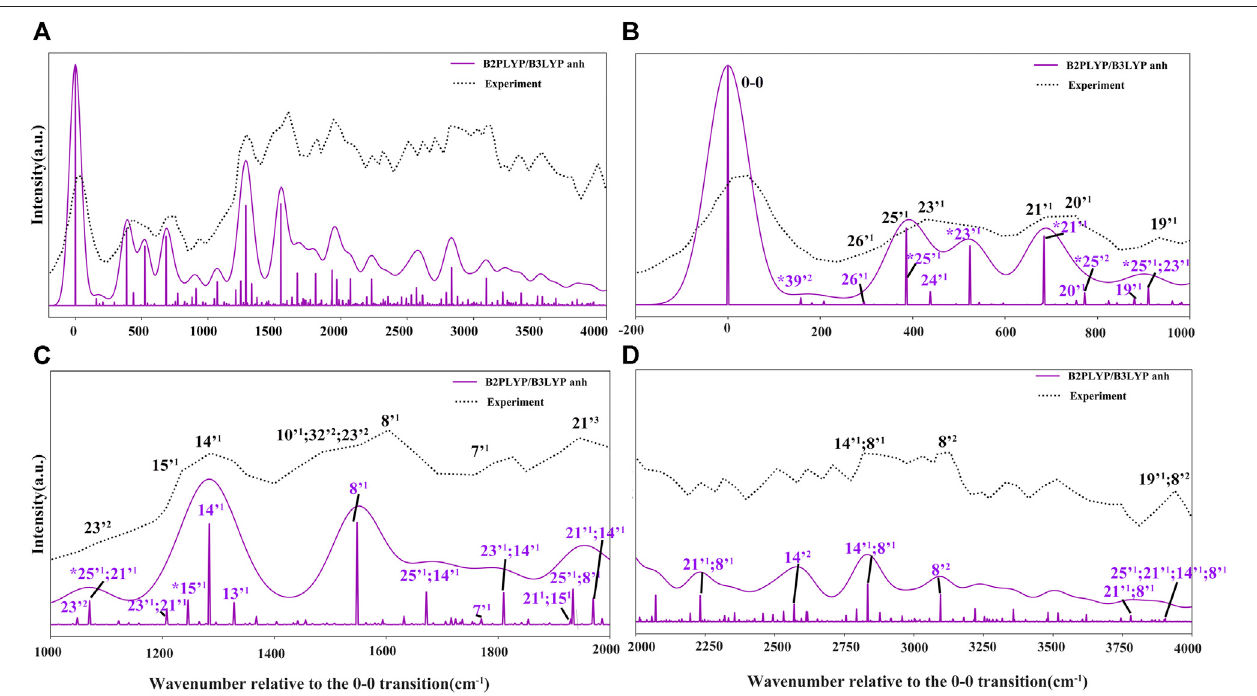
FIGURE 7 | Photoelectron TI AH|FC spectrum (60 K) and SPES experimental spectrum (Majdi et al., 2015). The computed spectrum is represented as single transitions,withmostintenseonesassignedas m n ,whichrepresents the fi nalvibrationalstatewith n quantaassociatedtomode m .Theconvolutedspectraline-shapes have been obtained by broadening with Gaussian function with HWHM of 50 cm − 1 . Bands observed also in the VUV-MATI experimental spectrum (Choi et al., 2005; Bravaya et al., 2010) are marked by asterisk (*).